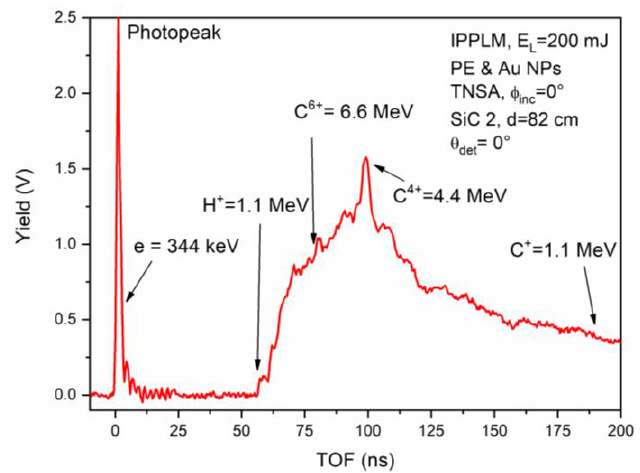
Figure 5. SiC-TOF forward spectrum obtained by irradiating a thin foil of PE+ Au NPs 6 μm thick in the TNSA regime at high laser contrast. the TNSA regime at high laser